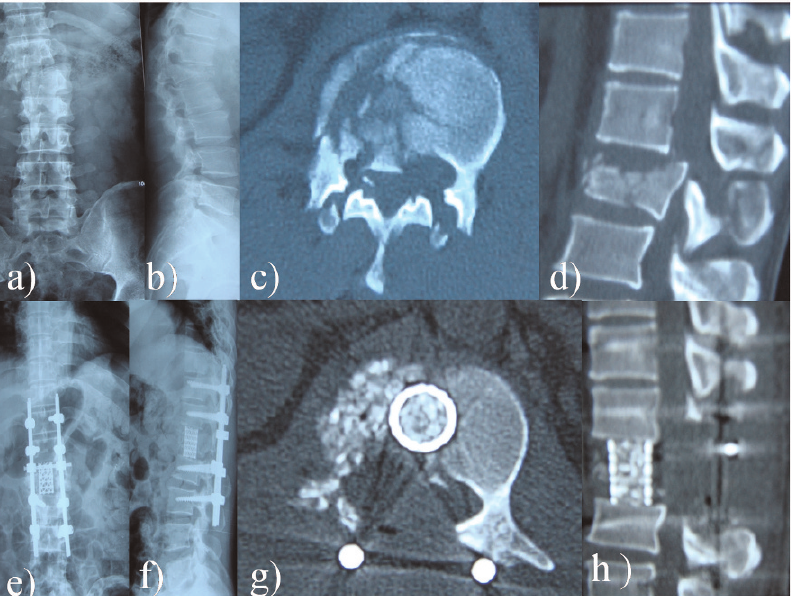
Figure 1 - Typical case one: a) and b) the preoperative X-ray shows an L1 fracture and dislocation; c) and d) preoperative CT scan of the L1 vertebral body; e) and f) the postoperative X-ray of L1 vertebral body shows that the fracture achieved good reduction; g) and h) postoperative CT scan of the L1 vertebral